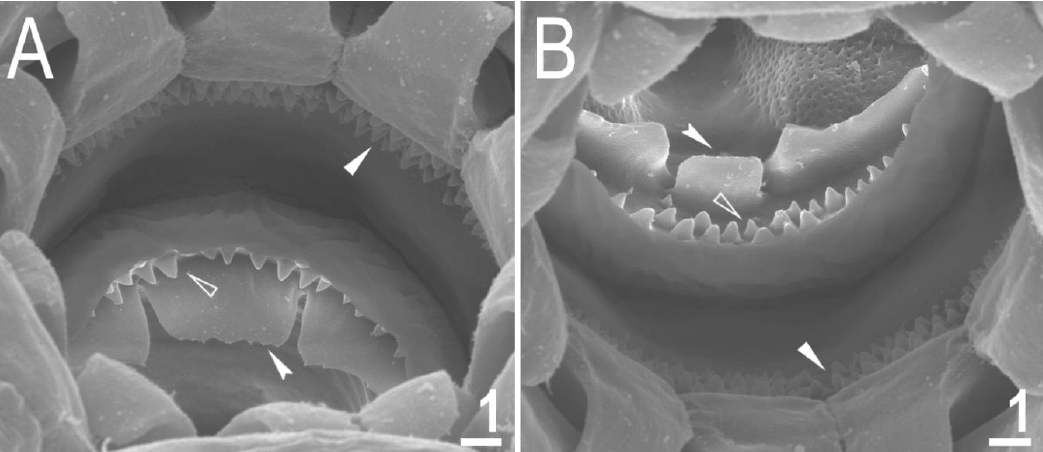
Figure 6. Macrobiotus rebecchii sp. nov. mouth opening and the oral cavity armature seen in SEM: ( A , B ) the oral cavity armature of a single paratype seen in SEM from different angles, dorsal ( A ) and ventral ( B ) view, respectively. The filled flat arrowheads indicate the first band of tenth, the empty flat arrowheads indicate the second band of teeth, and the filled indented arrowheads indicate the third band of teeth. Scale bars in μm.